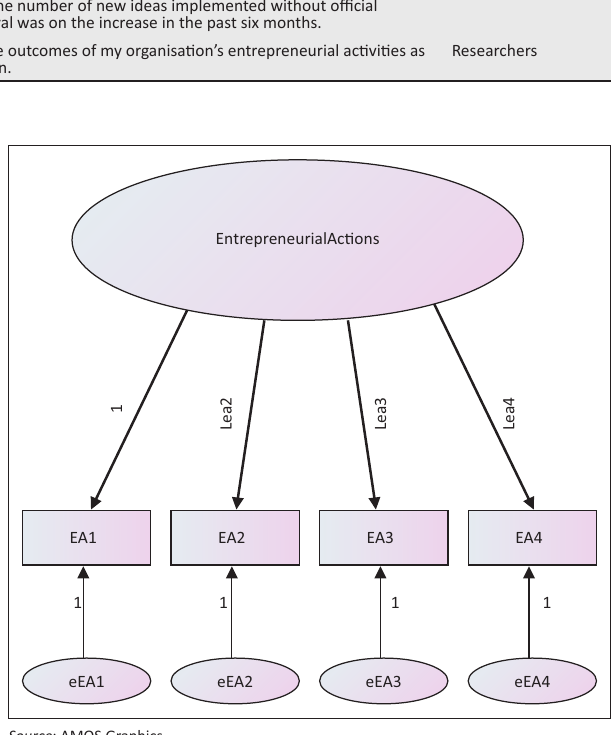
FIGURE 1: Hypothesised Confirmatory Factor Analysis model for entrepreneurial actions for sustainable corporate entrepreneurship.